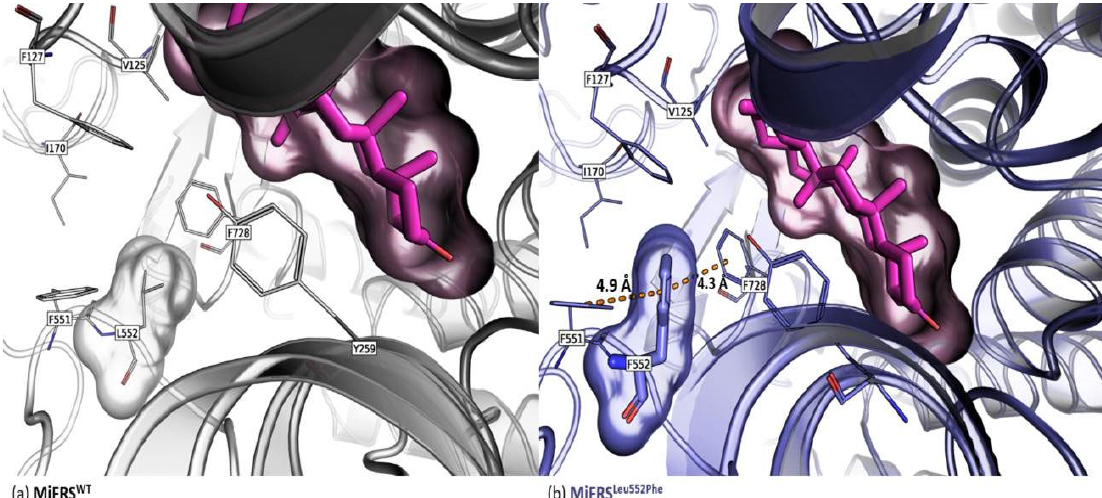
Figure 5. Secondary alignment (or side-by-side representation) of wild protein ( Mi FRS) (gray-lines carbons) with the Mi FRS Leu552Phe mutant (blue-lines carbons). The surface highlights the volume adopted by the friedelin molecule in the catalytic cavity. The blue stick residue indicates the mutated residue. ( a ) The mutation approached the Phe728 (not shown) residue of catalytic site, with a π -electron type interaction that stabilizes the C-ring, decreasing the enzyme specificity. ( b ) Another possibility of rotamer is impaired due to the collapse of other main or side chain residues.